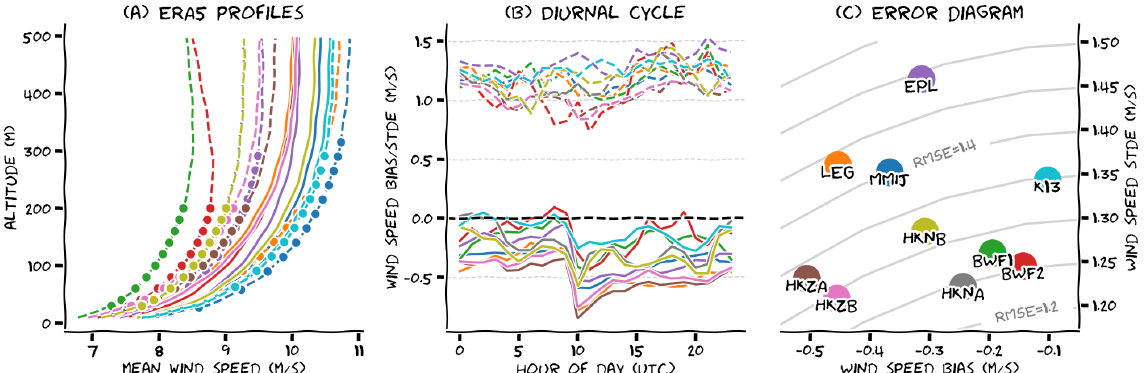
Figure 3. (a) Averaged wind speed profiles for each measurement location, based on 10 years of ERA5 data (full lines) and data subsets (dashed lines). (b) Mean (full lines) and standard deviation (dashed lines) of the error between ERA5 (subsets) and the observations, for each measurement site, as a function of the time of the day. (c) Error diagram of wind speed in ERA5 (subsets) versus observations for all lidar datasets. Colour coding is the same in all subplots, so (c) can serve as a legend.